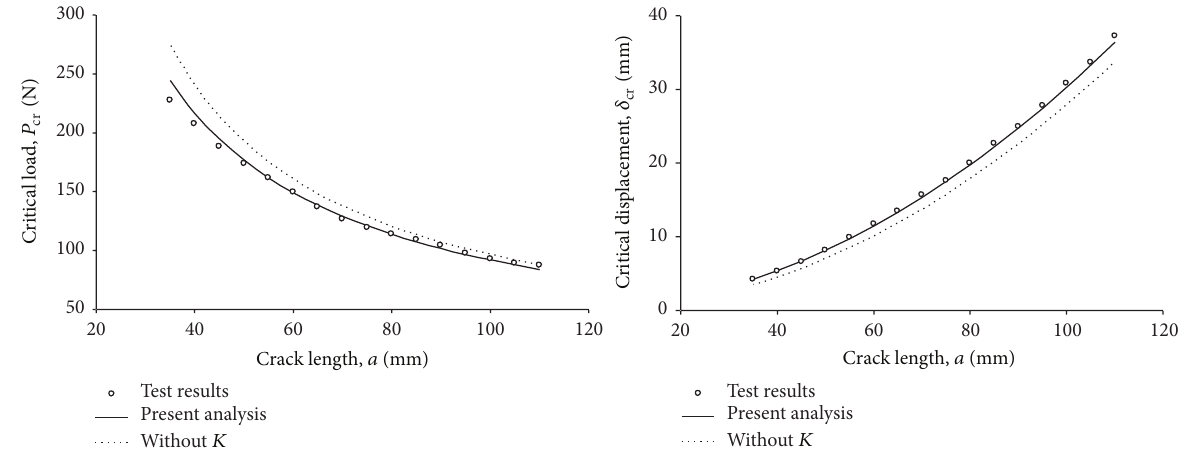
) and the corresponding displacement (𝛿 ) with cr cr